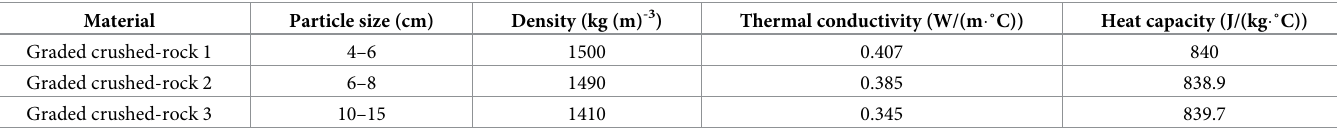
Table 8. Thermal parameters of varied subbase